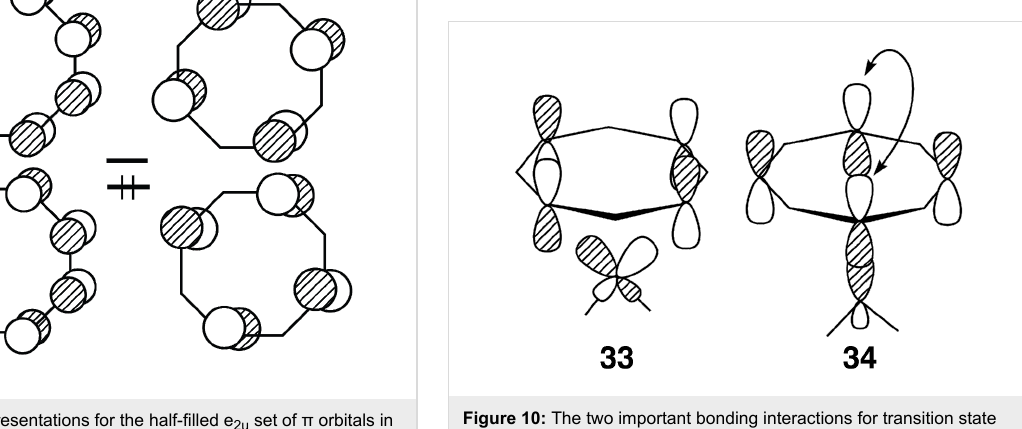
Figure 8: Two representations for the half-filled e 2u set of π orbitals in cyclooctatetraene.